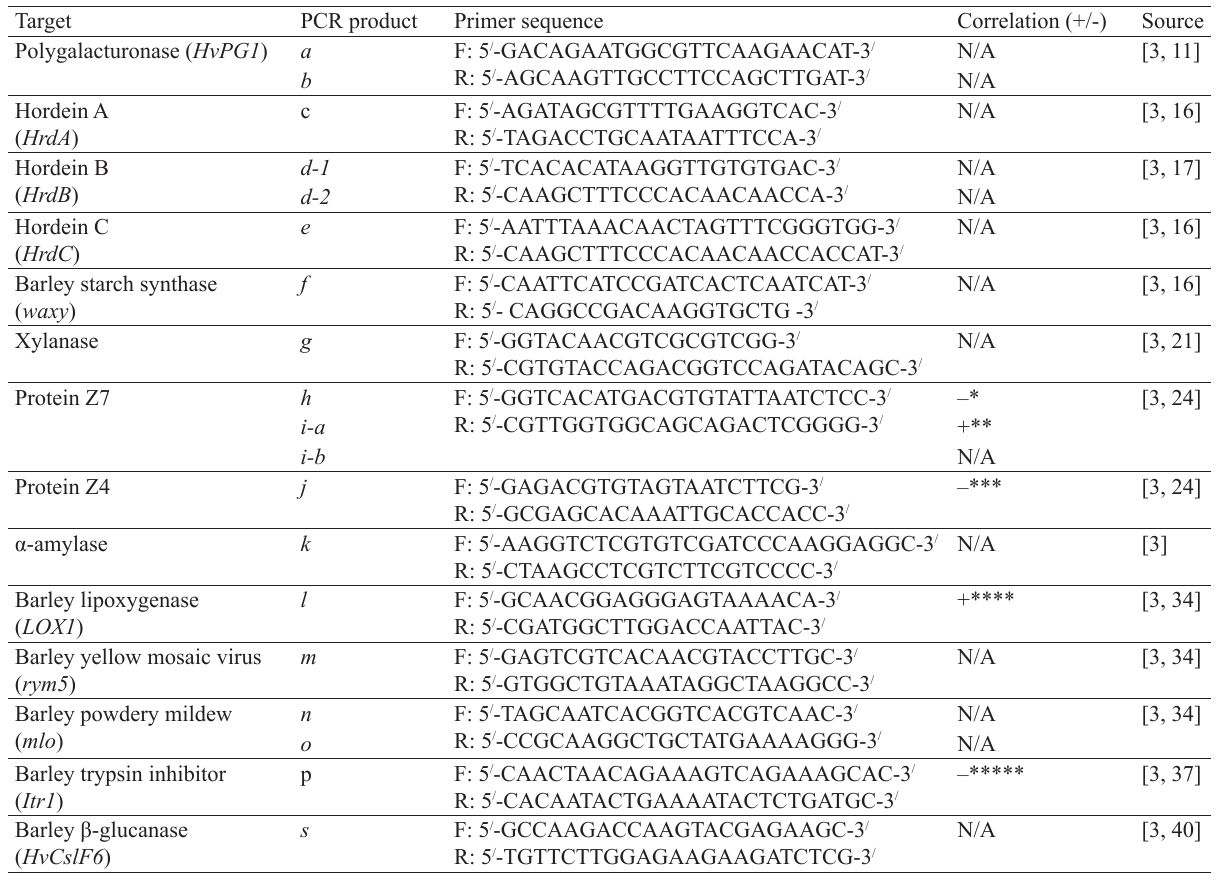
Table 1 Genetic targets used as molecular markers for brewing barley varieties identification and beer DNA authentication Target PCR product Primer